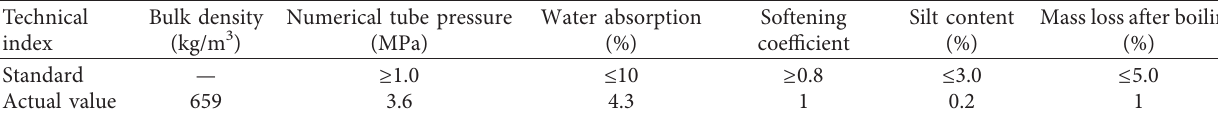
Table 4: Performance indices of shale ceramsite.